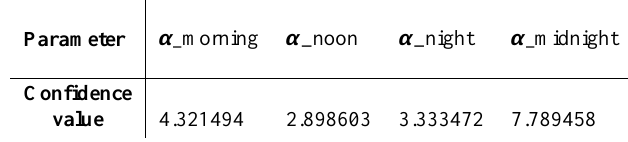
Table 3: The results of the crime distribution model based on daily